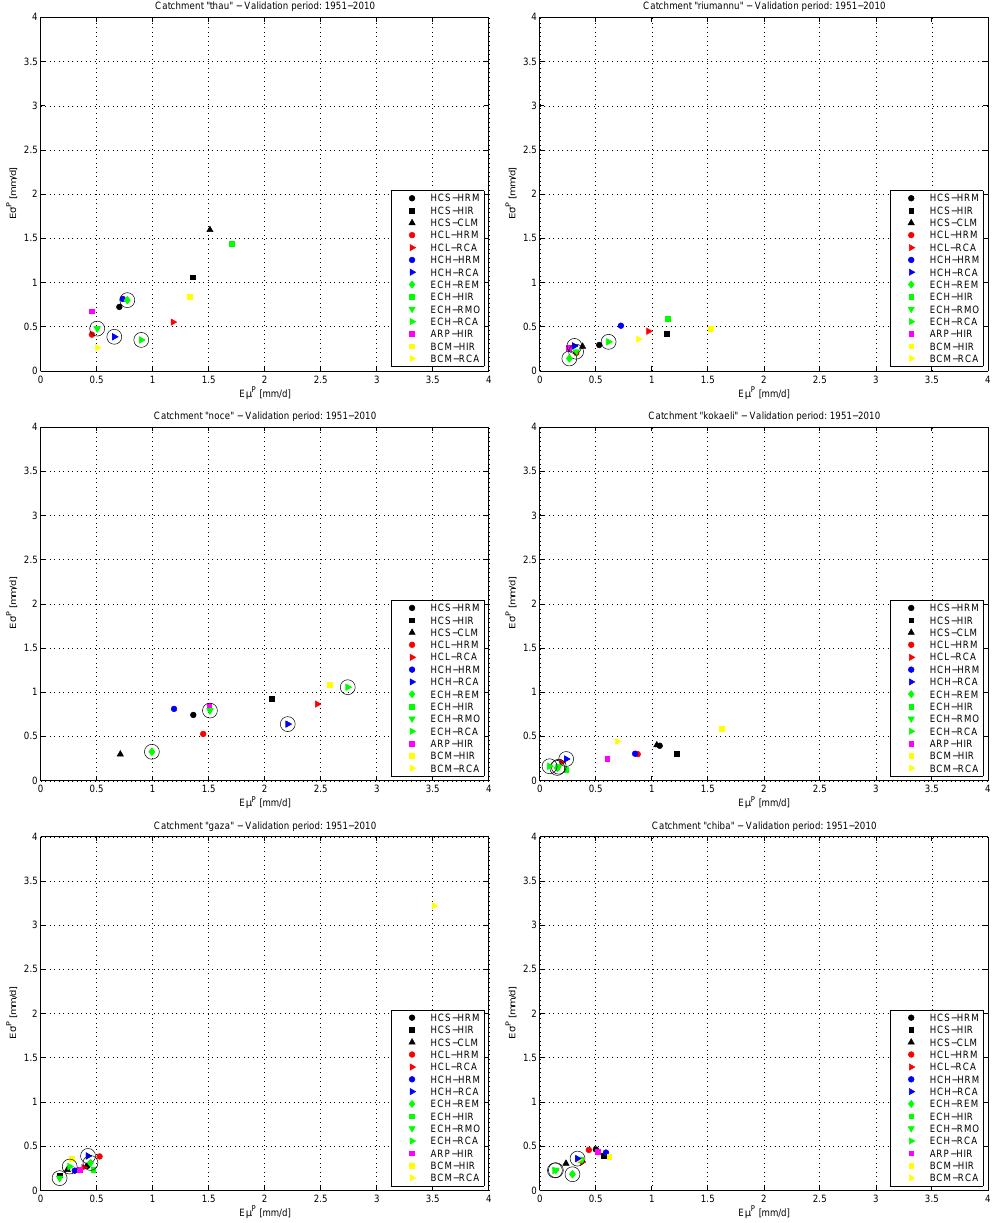
Fig. 5. Scatterplot of errors in the mean and standard deviation of monthly precipitation ( mm d (cid:0) 1 ) over the Fig. 5. Scatter plot of errors in the mean and standard deviation of monthly precipitation (mmd − 1 ) over the 60yr verification period (1951– 60yrverificationperiod(1951–2100), computedusingEqs. (3)and(4)foreachofthe14ENSEMBLESmodels 2010), computed using Eqs. (3) and (4) for each of the 14 ENSEMBLES models with respect to E-OBS observational reference. Each subplot with respect to E-OBS observational reference. Each subplot displays areal averages over a 4 (cid:2) 4 grid-point displays areal averages over a 4 × 4 grid-point stencil centered in each stencil centered in each catchment.